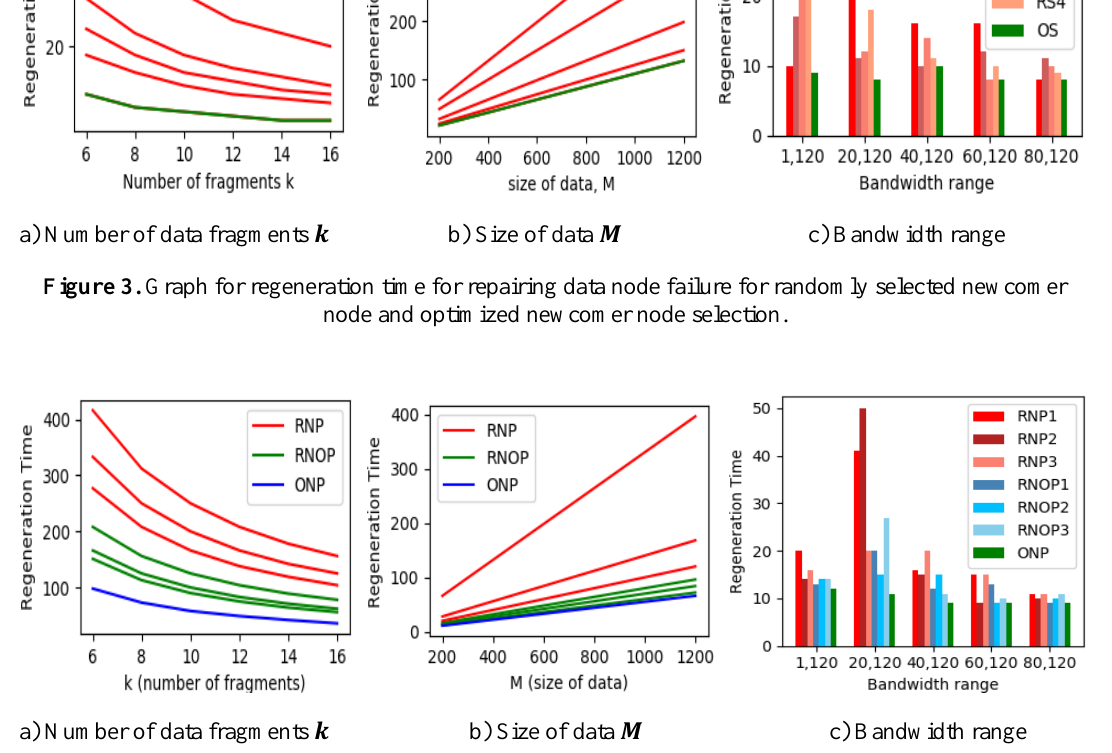
Figure 4. Graph for regeneration time for repairing parity node failure for RNP, RNOP and